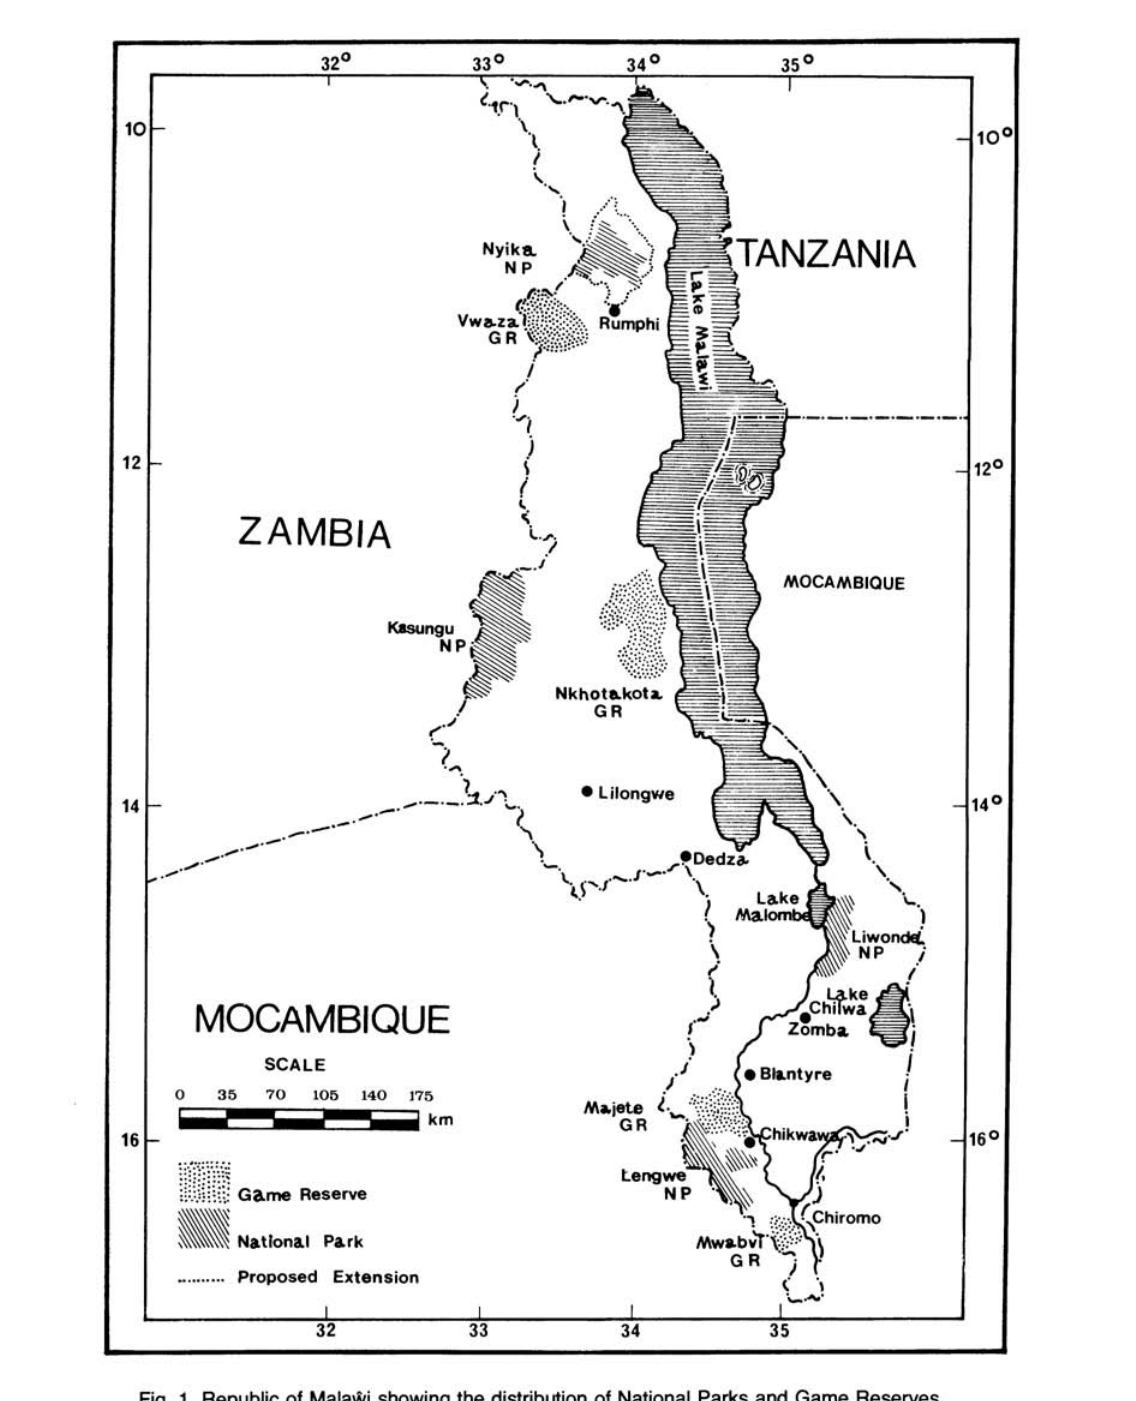
Fig. 1. Republic of Malawi showing the distribution of National Parks and Game